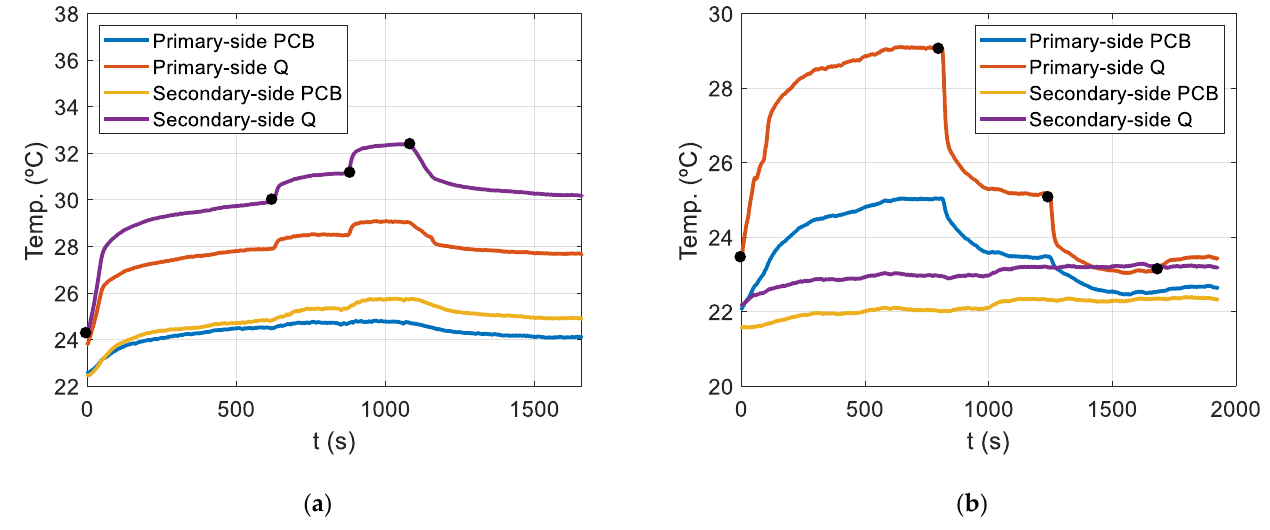
Figure 15. Temperature evolution. ( a ) DAB-FPP; ( b ) DAB-PPP.